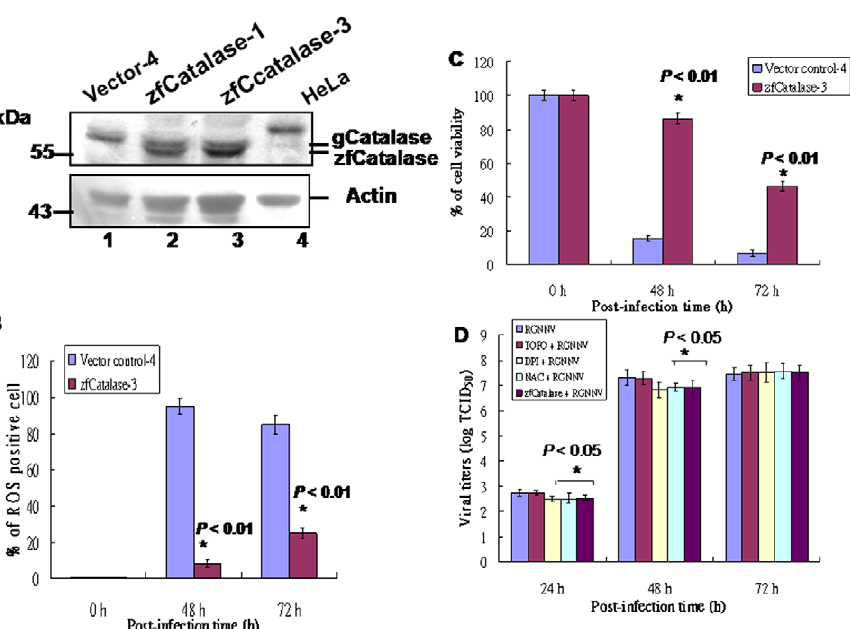
Figure 5. Identification of zebrafish catalase overexpression can reduce RGNNV-induced ROS-mediated cell death and viral titers in GF-1 cells. (A) Western blot analysis of zebrafish catalase-producing cell lines in GF-1 cells after selection with Zeocin (500 m g/ml). The stable clones are zfCatalase-1 (lane 2), zfCatalase-3 (lane 3), and vector control-4 (lane 1). HeLa cell lysate serves as a positive control (lane 4). Actin used as an internal loading control. (B) The number of ROS-producing cells after infection with RGNNV (MOI=1) at 0, 48, and 72 h. Statistical comparisons were made using either a paired or unpaired Student’s t -test, as appropriate. * P , 0.01. (C) The viability of cells transfected with vector control-4 or zfcatalase-3 and infected with RGNNV was determined at 0, 48, and 72 h pi in triplicate by using a trypan blue dye exclusion assay [37]. Statistical comparisons were made using either a paired or unpaired Student’s t -test, as appropriate. * P , 0.01. (D) Viral titers were assays in GF-1 cell line by using at 48 h and 72 h pi samples. Statistical comparisons were made using either a paired or unpaired Student’s t -test, as appropriate. * P ,